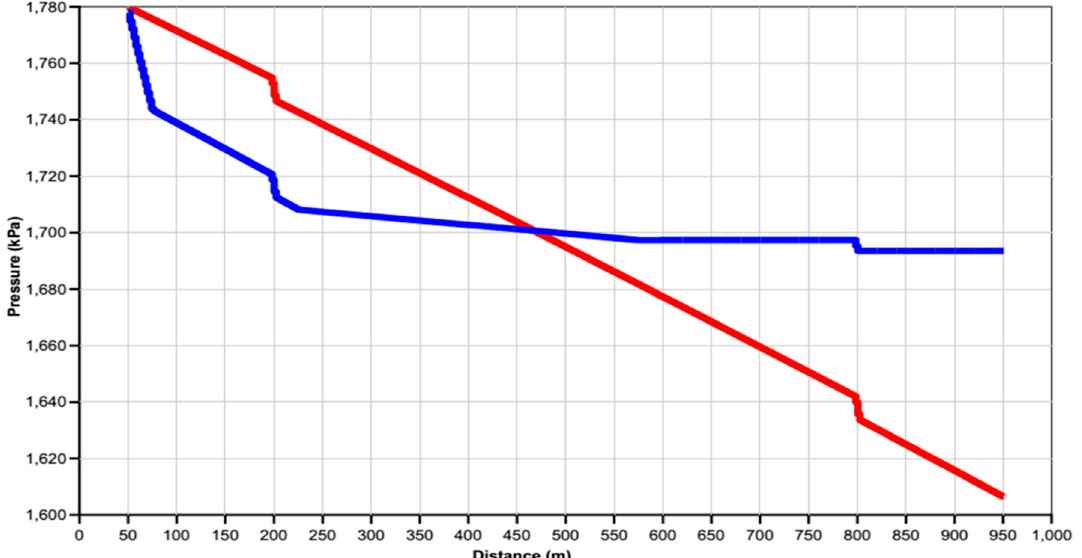
Figure 11. Injector long tubing pressure profiles, optimized OCDs (blue line), and dual-string cases (red line).